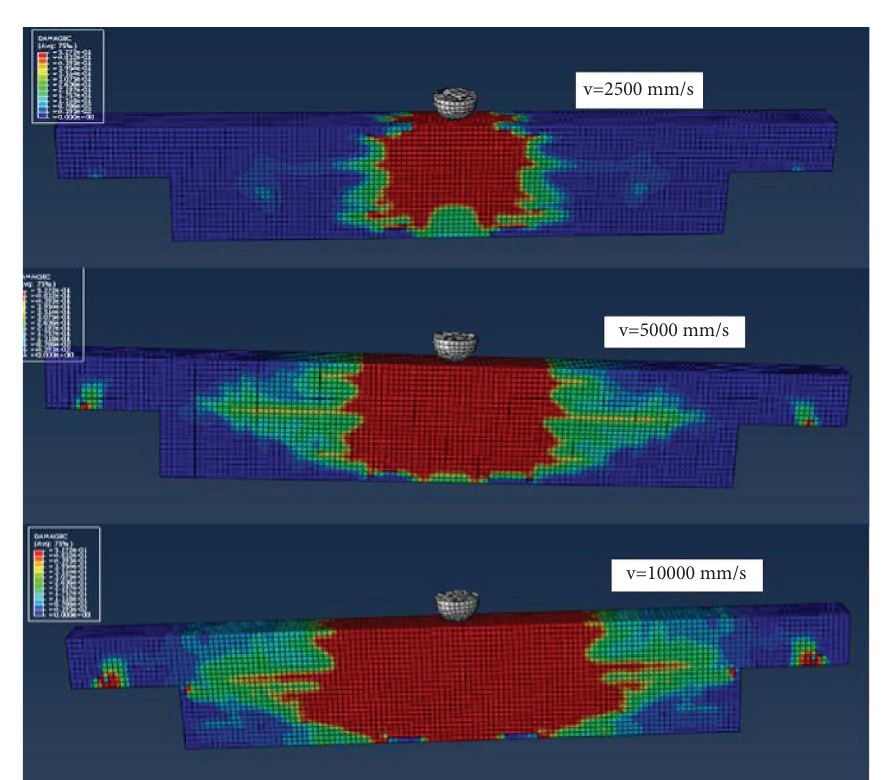
Figure 8: Damage of RC dapped-end beam under diferent impact